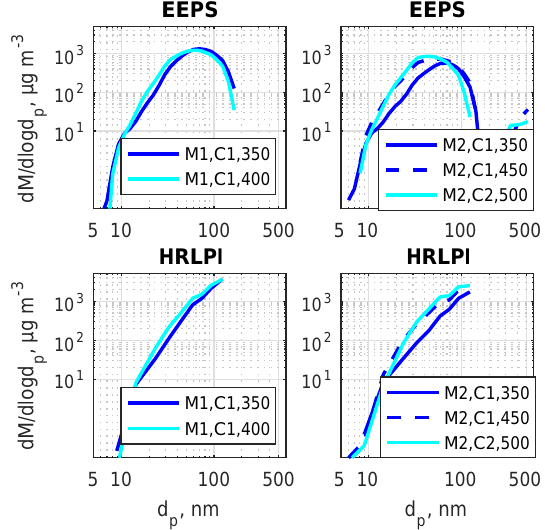
Figure 5. Particle mass size distributions measured by EEPS and HRLPI and corrected by the dilution ratios. Cases M1, C1 are on the left, and cases M2, C1 and M2, C2 are on the right. Cyan curves stand for the higher catalyst temperatures and blue for the lower ones.